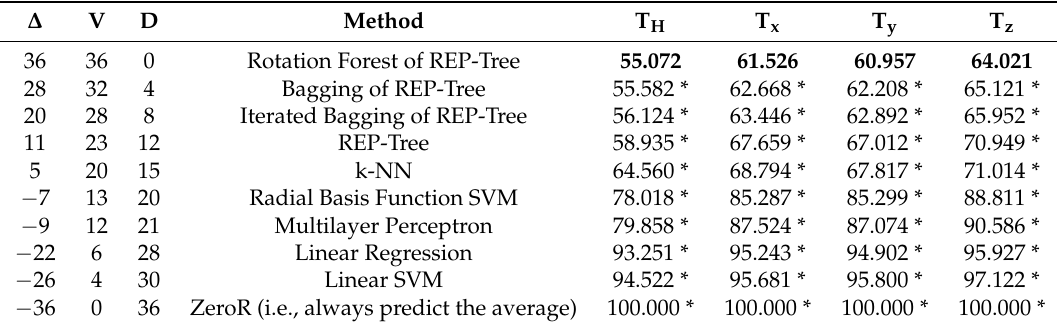
Table 6. Ranking of RRSE in the regression problems. V is the number of times the method has a better statistically significant RRSE when compared with the other 9 methods through the 4 predicted variables. D is the number of times the method has a worse statistically significant RRSE when compared with the other 9 methods through the 4 predicted variables. The ordering criteria ∆ , is equal to V – D. The columns T H , T x , T y and T z have the average RRSE figures for the method using 10 × 10CV. (*) represents this method has an average RRSE that is significantly worse than the one for the best ranked method. The best RRSEs for each predicted variable are highlighted in bold.